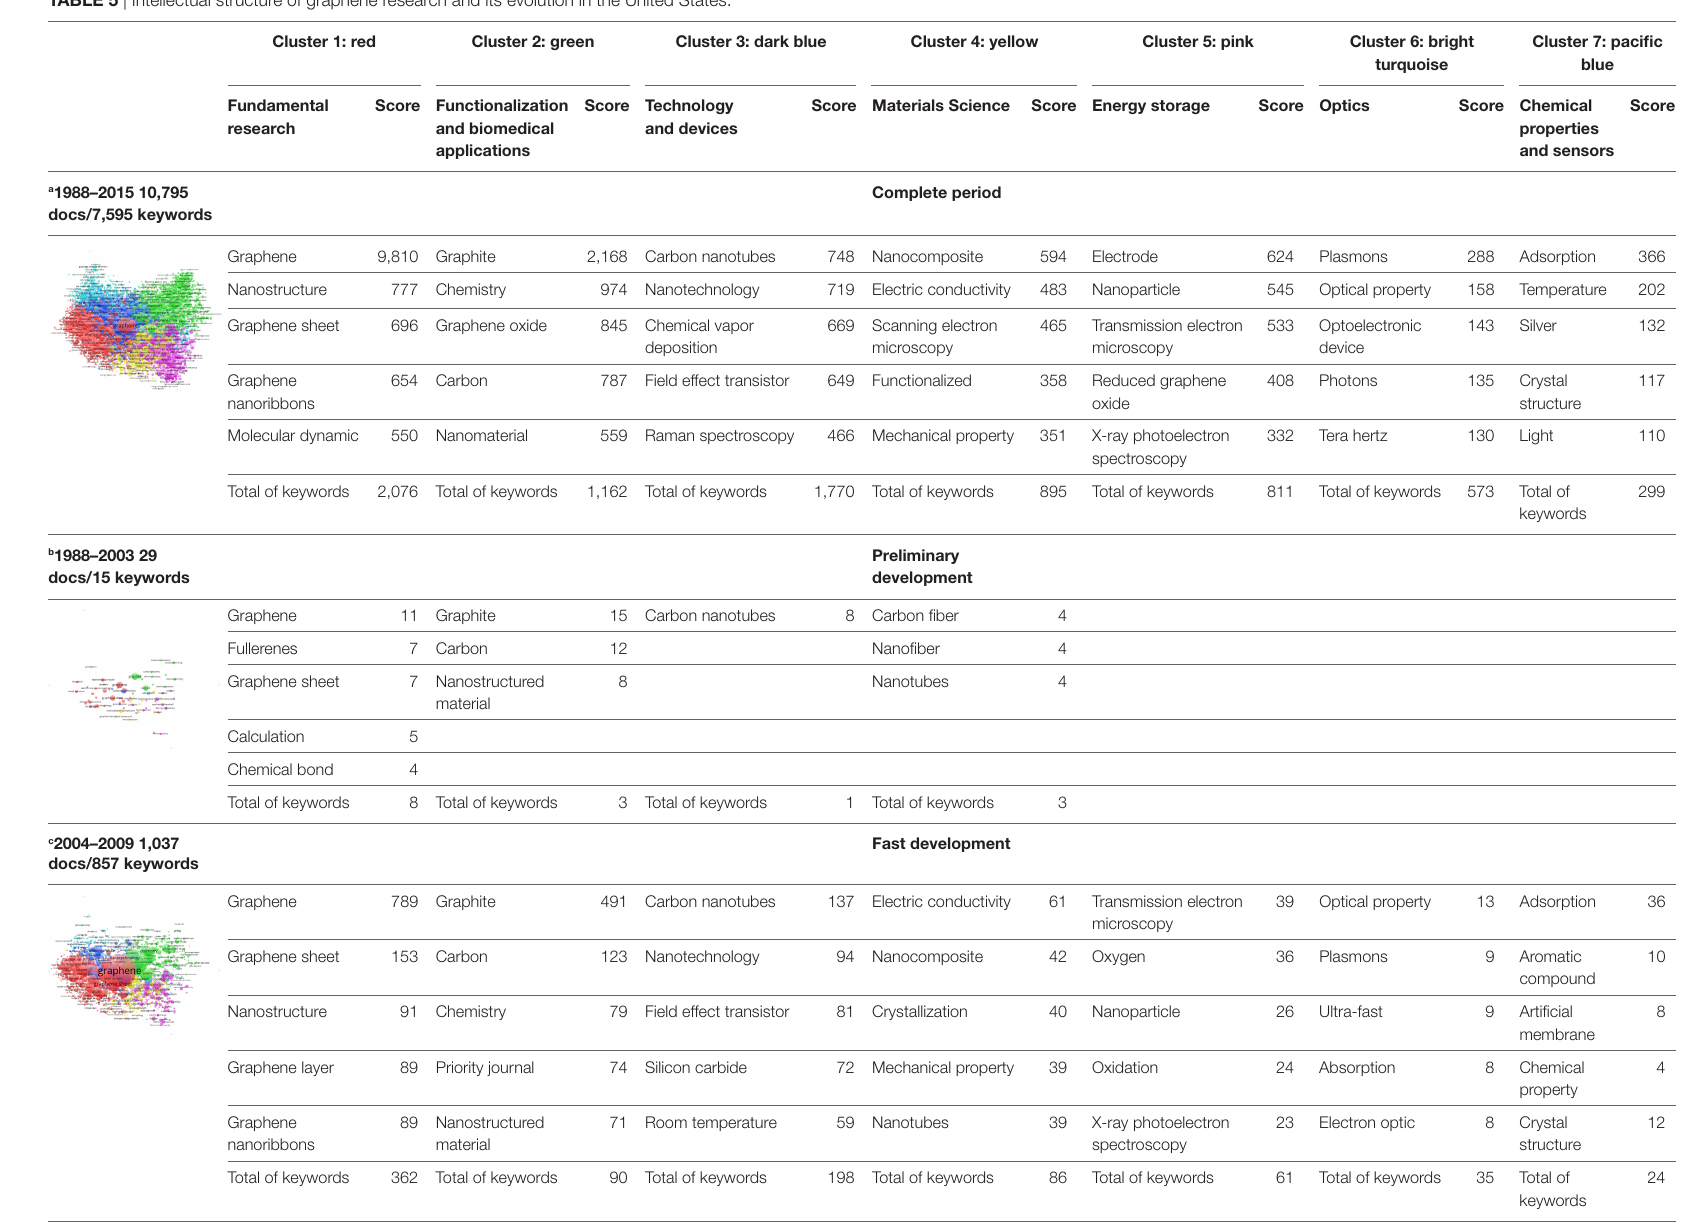
TaBle 5 | Intellectual structure of graphene research and its evolution in the United